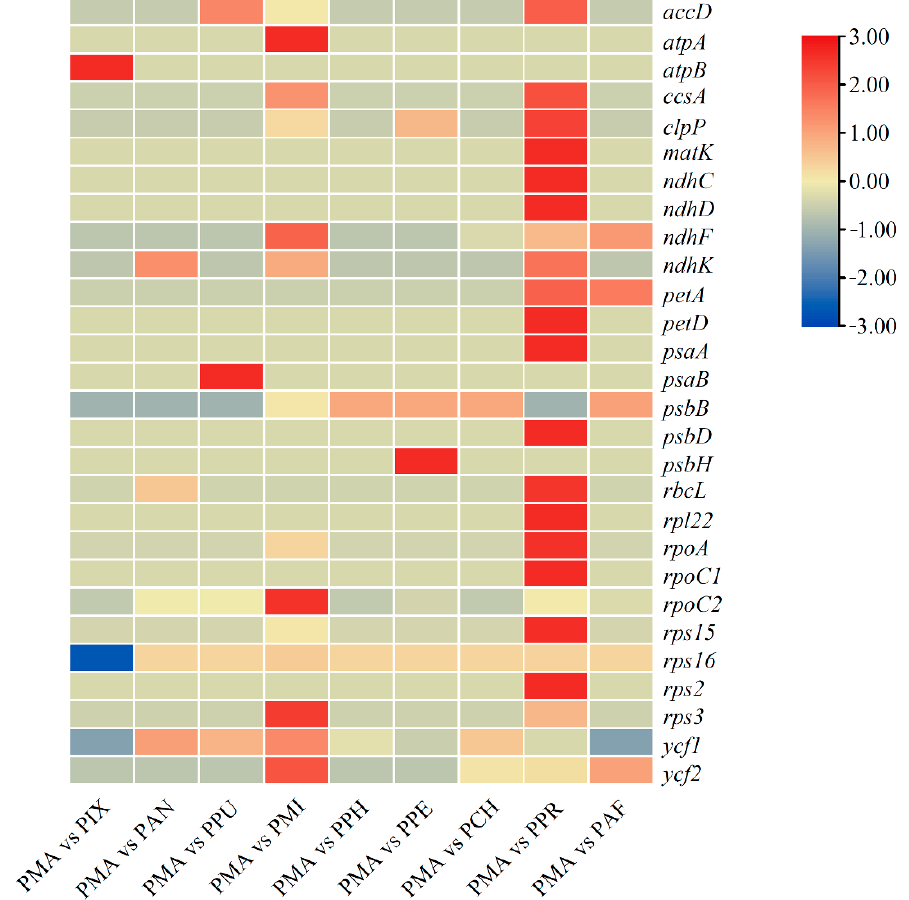
Figure 8. The heatmap for the evolutionary dynamics of the protein-coding genes among the 10 Physalis cp genomes. Genes with value of Ka/Ks = 0 or uncalculatable are not shown.